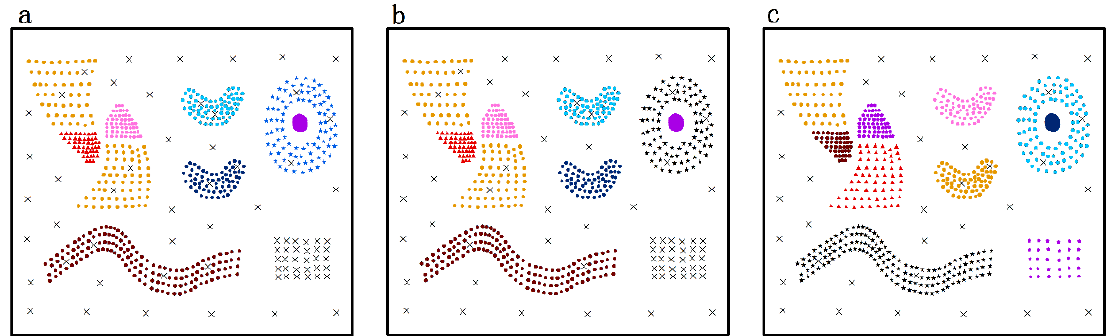
Figure 15. Clustering results on 𝑆1 with proposed similarity measurements and typical similarity measurements: ( a ) result with proposed similarity measurements; ( b ) result with Euclidean distance; and ( c ) result with Pearson correlation coefficient. ISPRS Int. J. Geo-Inf. 2016 , 5 , 205